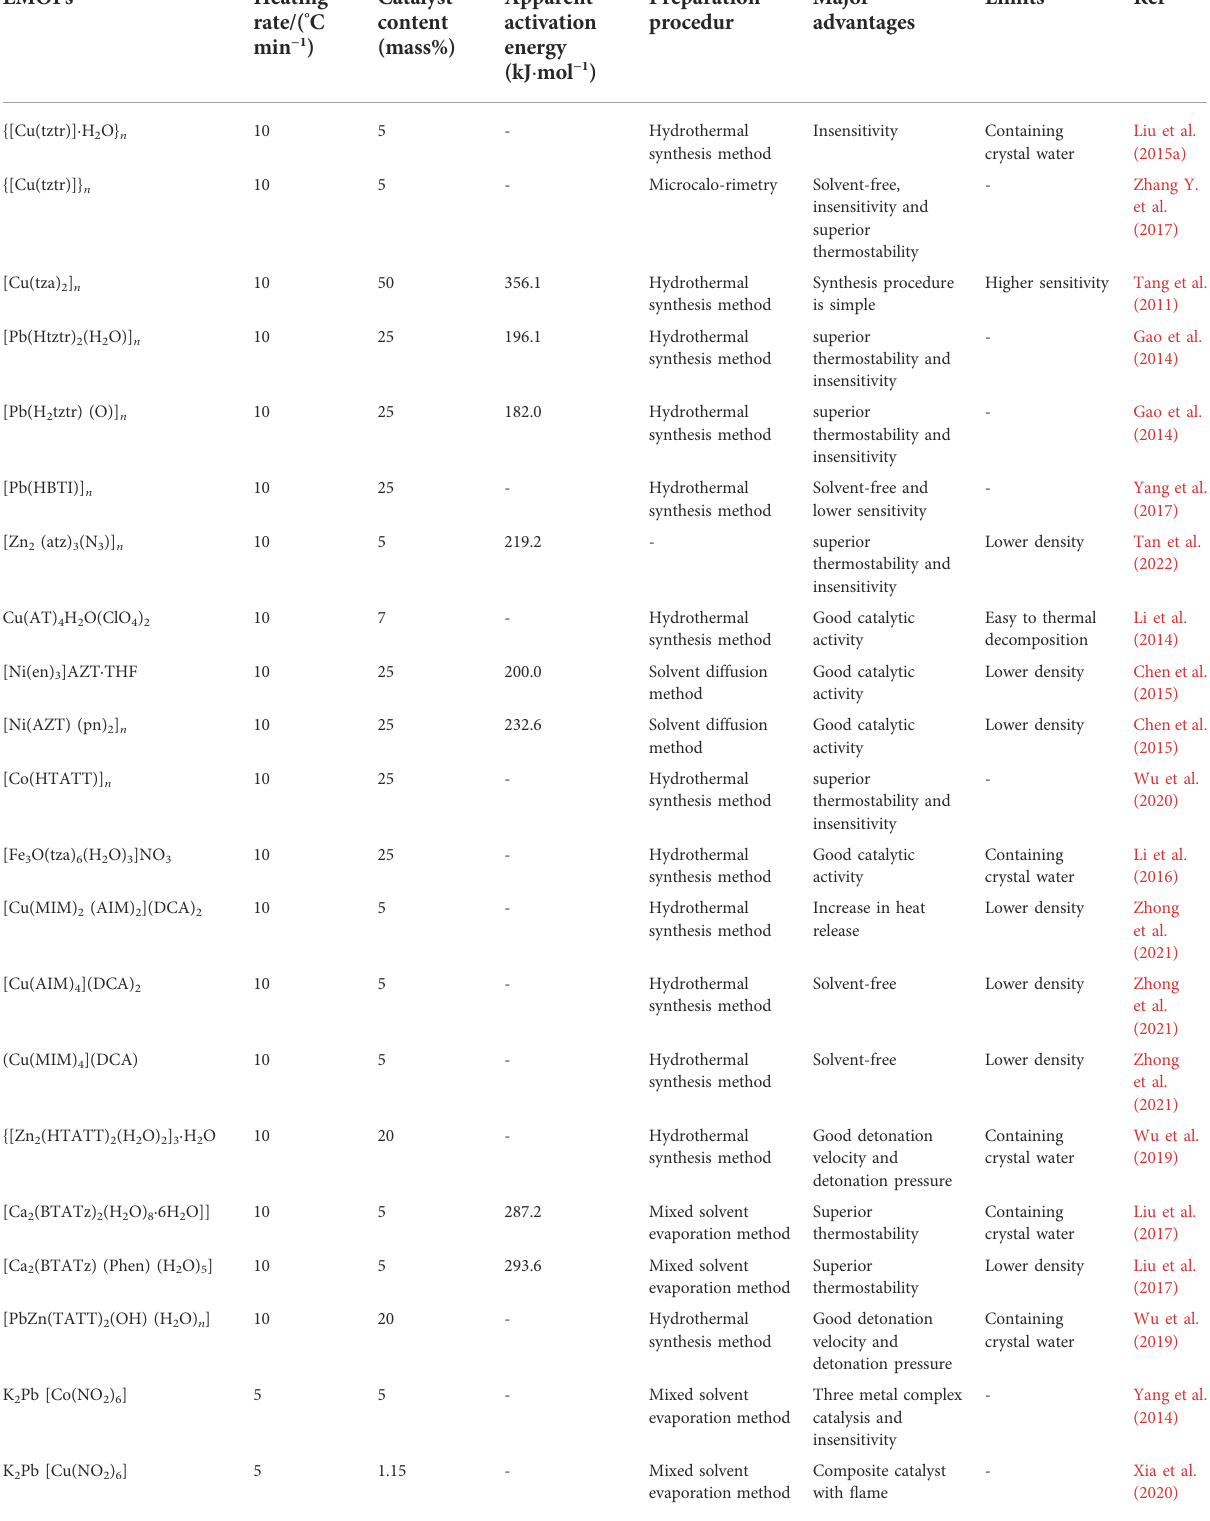
TABLE 2 The summary of novel energetic burning rate catalysts and some classical energetic